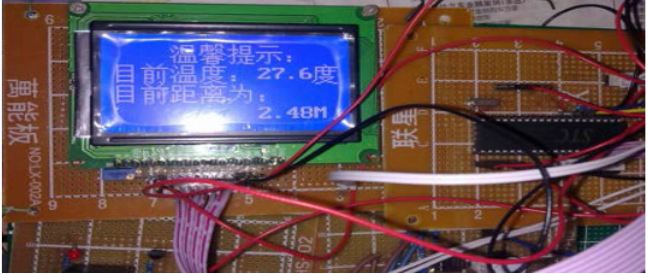
Fig. 2 . Sensors collect data in real time.